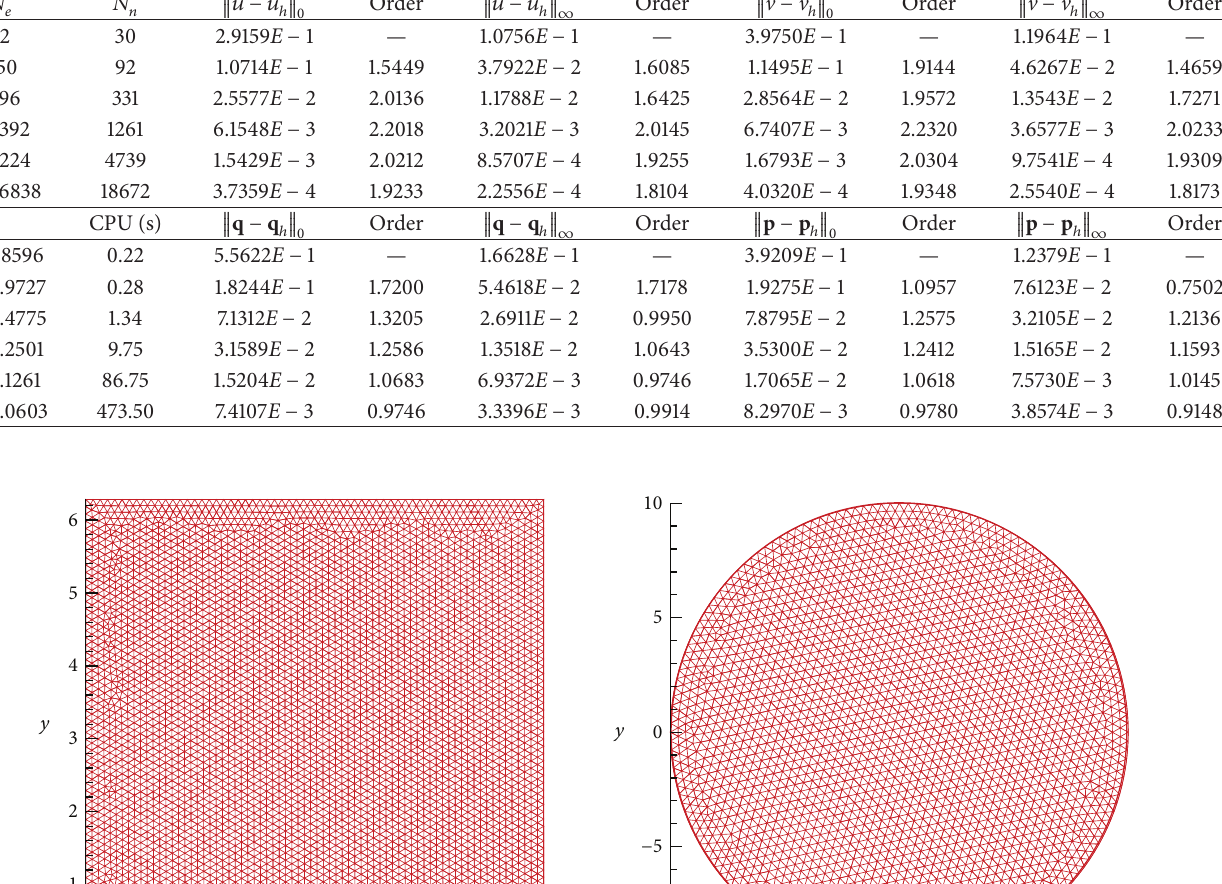
2 and here 𝑏 11 = 𝑏 22 = 1 , 𝑏 12